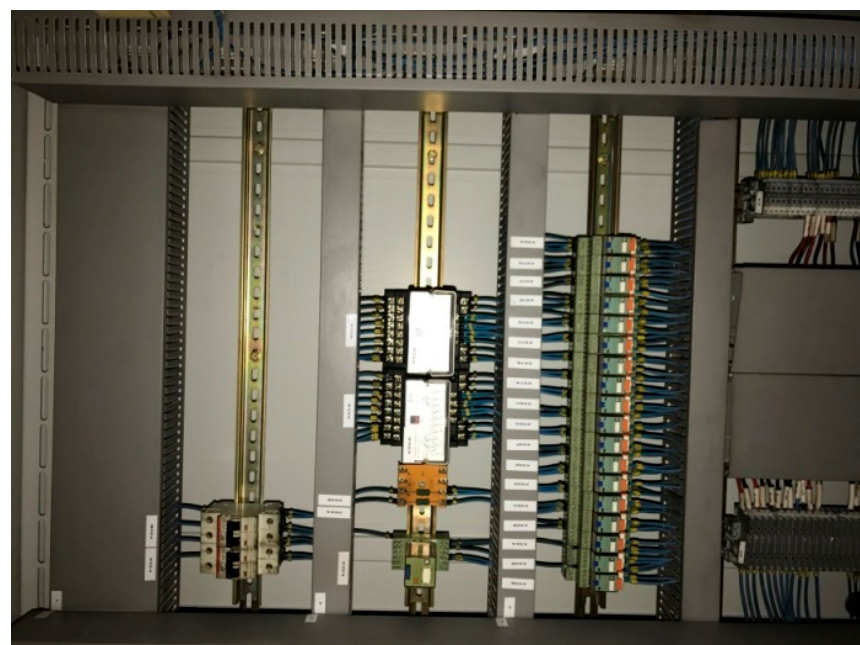
Figure 32. The panel before installing the relay.